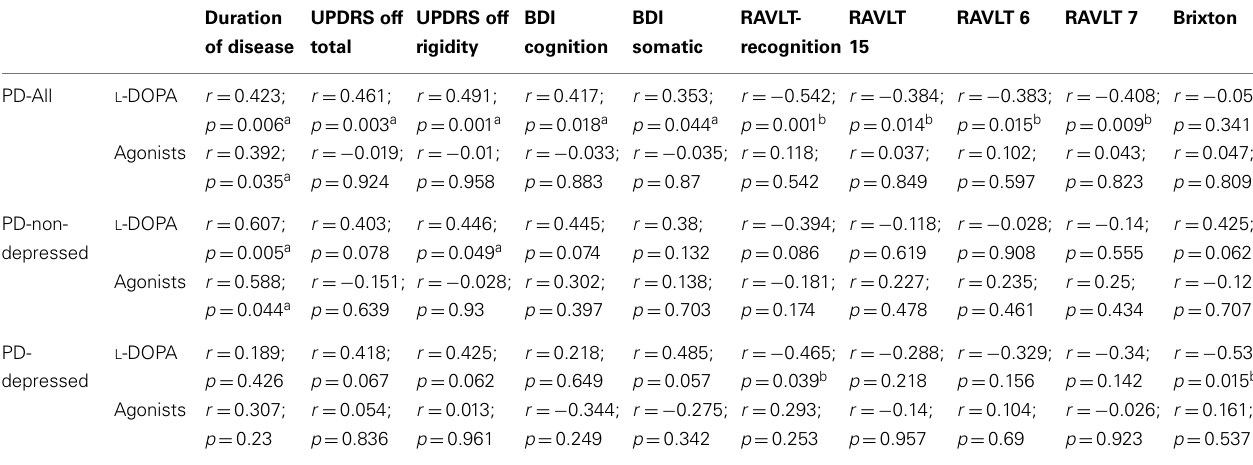
Table 3 | Correlation results between the groups